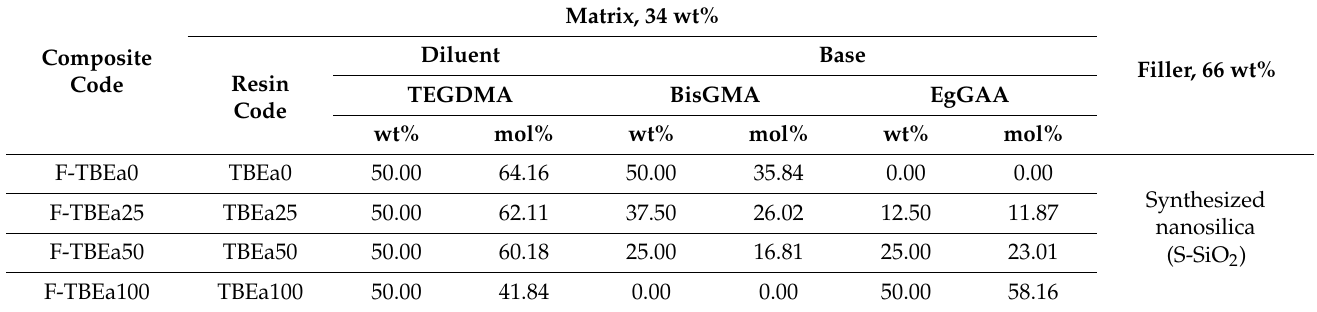
Table 1. Composition of matrices (TBEg (0–100)) and composites (F-TBEg (0–100)). Composites (F- TBEa0–F-TBEa100) consist of matrix and filler, matrices (TBEa0–TBEa100) combine base and diluent monomers, and the base monomers are either BisGMA or EgGAA or their